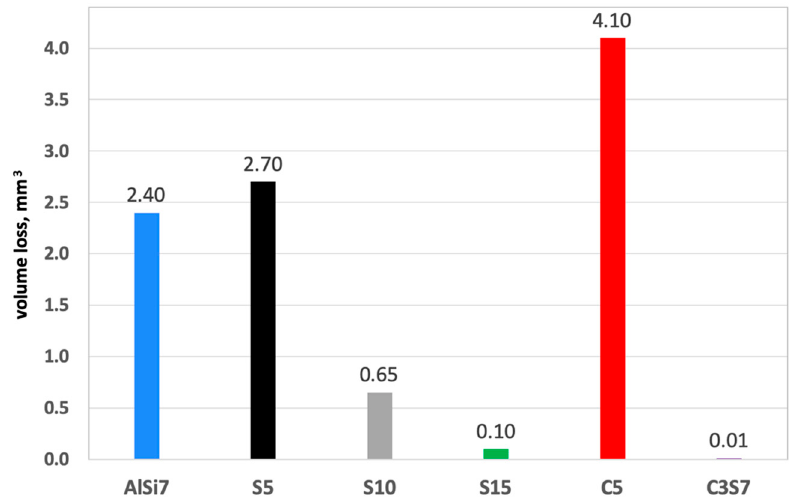
Figure 21. Volume loss of investigated single (S5, S10, S15 and C5) and hybrid composite layers (C3S7) compared with the un-reinforced matrix under dry sliding conditions, (accuracy of calculations 2 × 10 − 8 mm 3 ).